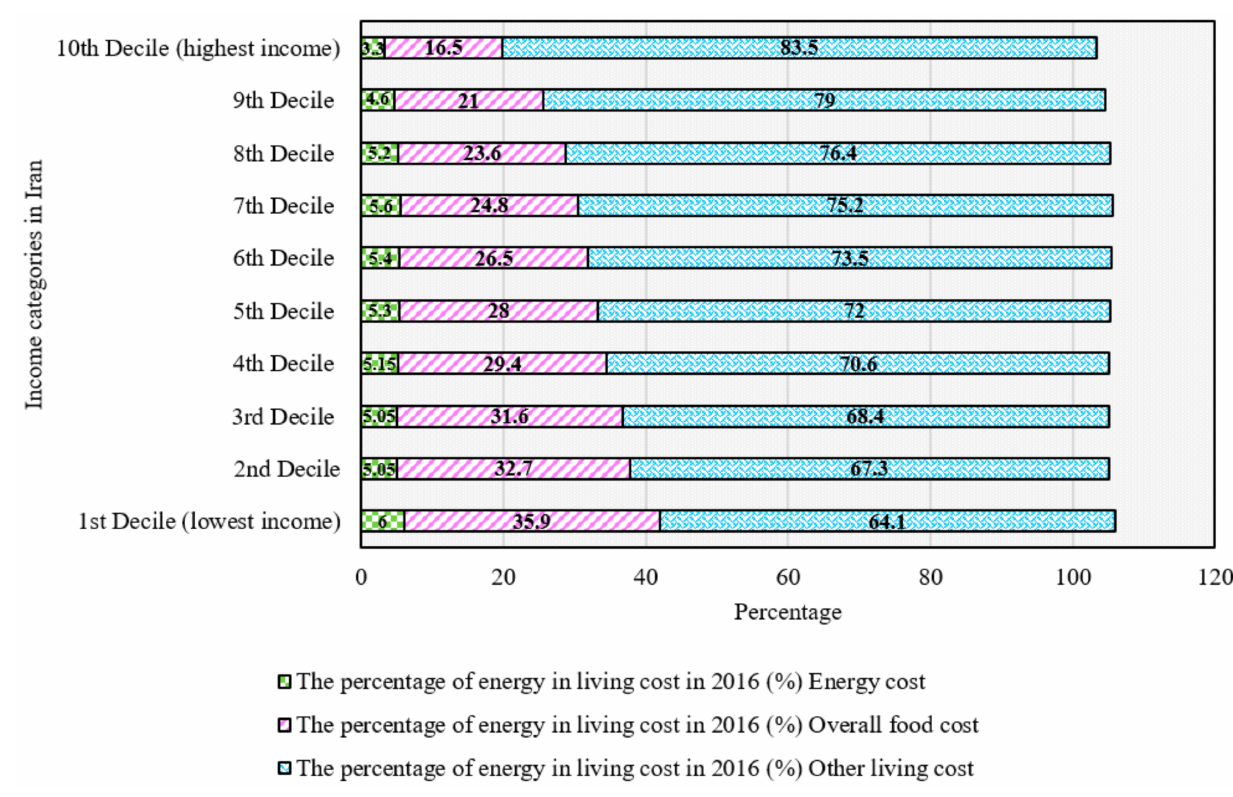
Figure 19. The portion of energy in living costs of income categories in Iran in